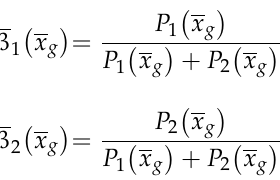
Table 1. Mean values of β(cid:3364) 1 and β(cid:3364) 2 for the six groups of x = log(T T ) within Z9.